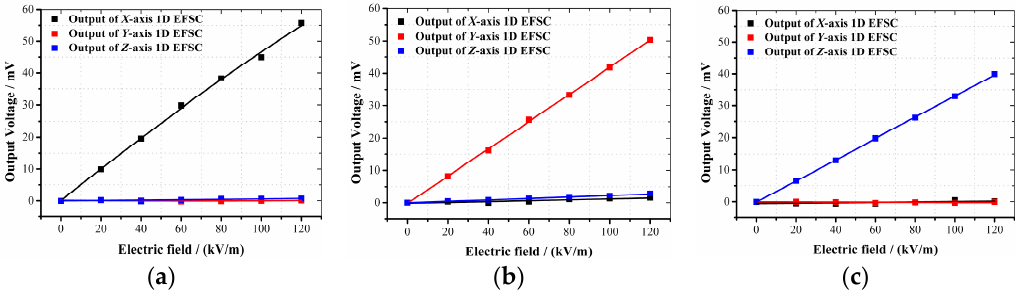
Figure 11. Uniaxial electric field calibration for the 3D EFS. ( a ) The electric field is applied along X -axis; ( b ) electric field is applied along Y -axis; ( c ) electric field is applied along Z -axis. Table 2. Sensitivities of the X -, Y - and Z -axis 1D EFSCs.